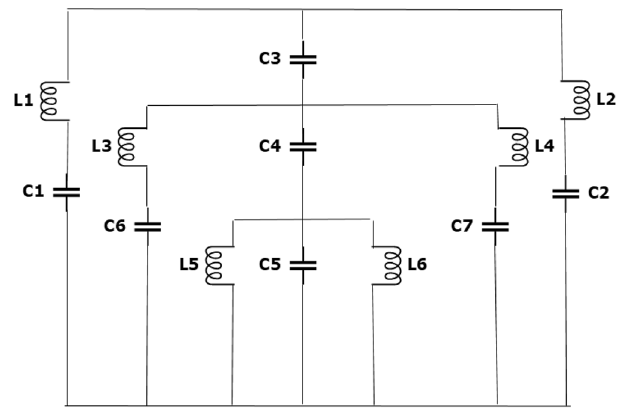
Figure 3. Equivalent circuit model.